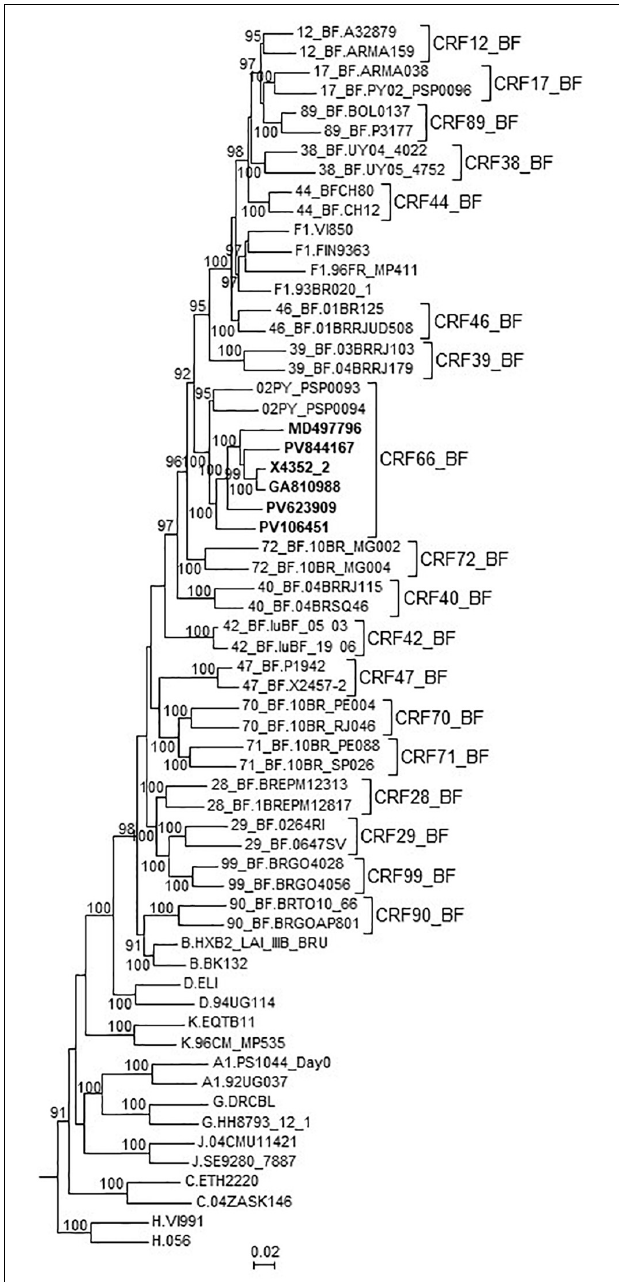
FIGURE 4 | Maximum likelihood tree of NFLG sequences of viruses of the BF9 cluster and PY02_PSP0094, constructed with IQ-Tree. References of all published CRF_BFs and of HIV-1 subtypes are also included in the analysis. The tree is rooted with SIVcpz virus MB66. Names of sequences obtained by us are in bold type. In reference sequences, the subtype or CRF is indicated before the virus name. Only ultrafast bootstrap values ≥ 90% are shown.